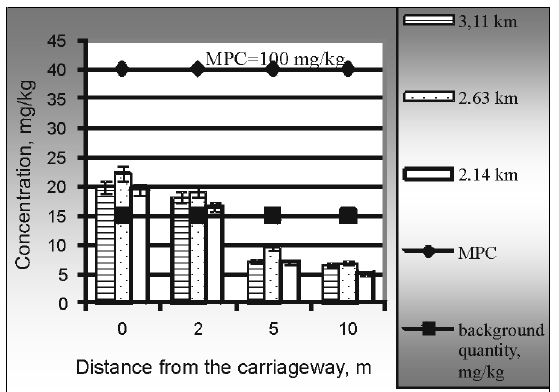
Fig. 11. Lead concentration in the roadside soil of the